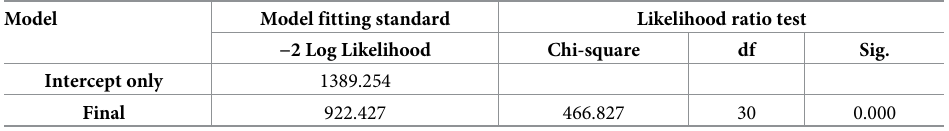
Table 6. Model fitting information.